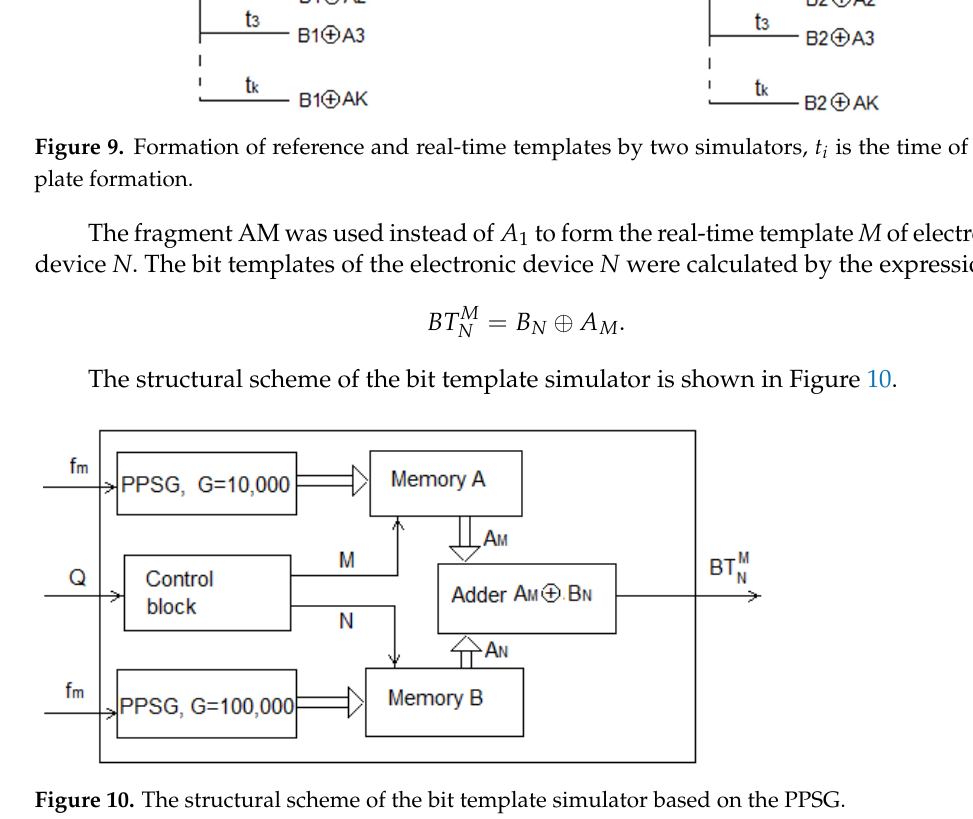
Figure 10. The structural scheme of the bit template simulator based on the PPSG.